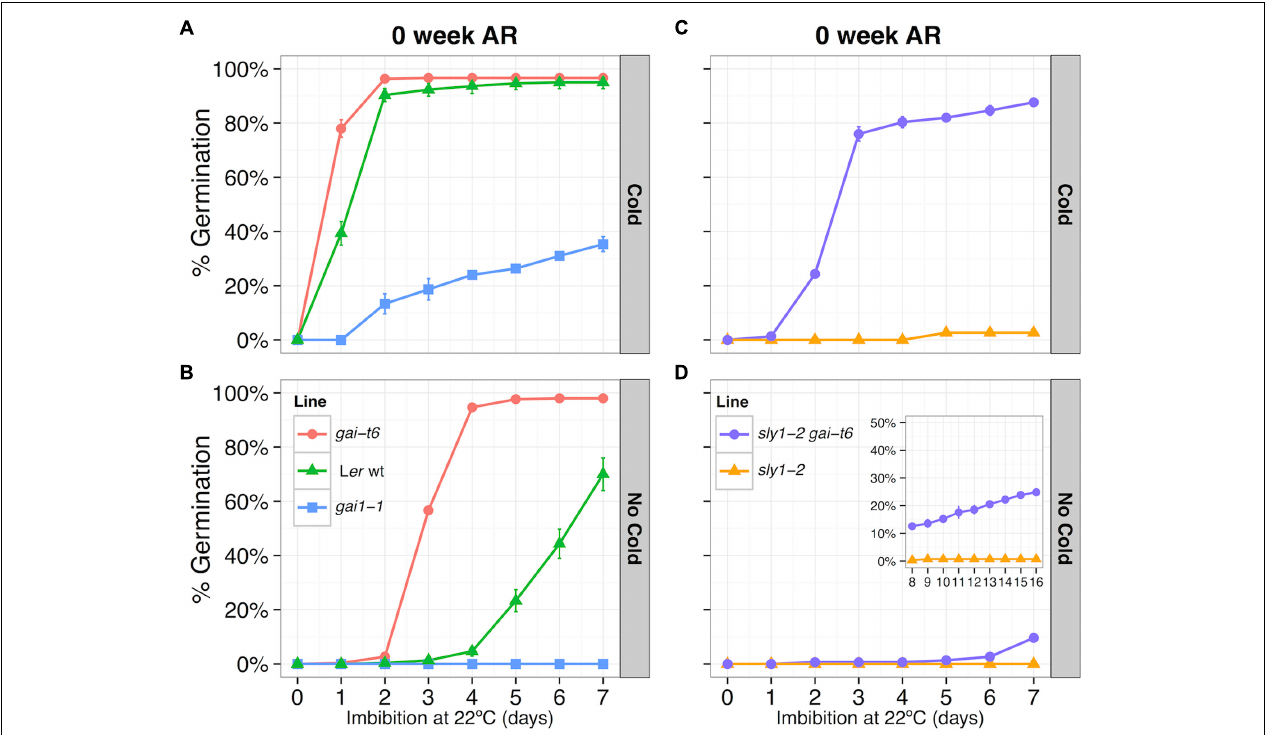
FIGURE 9 | Examining the role of GAI in the regulations of seed germination based on germination screens using freshly harvested seeds collected at near maturity. (A,B) Comparing of L er wt, gai-1 (gain of function allele), and gai-t6 germination: (A) with cold stratification for 4 days at 4 ◦ C, before moving to the light at 22 ◦ C where germination was scored daily (“Cold”), and (B) without cold, seeds placed directly at 22 ◦ C and germination scored daily (“No Cold”). Loss of GAI function leads to an increase in germination and gain of GAI function leads to increased dormancy. (C,D) Comparing sly1-2 and sly1-2 gai-t6 germination (C) with cold stratification, and (D) without cold stratification. Loss of GAI function caused partial rescue of sly1-2 seed